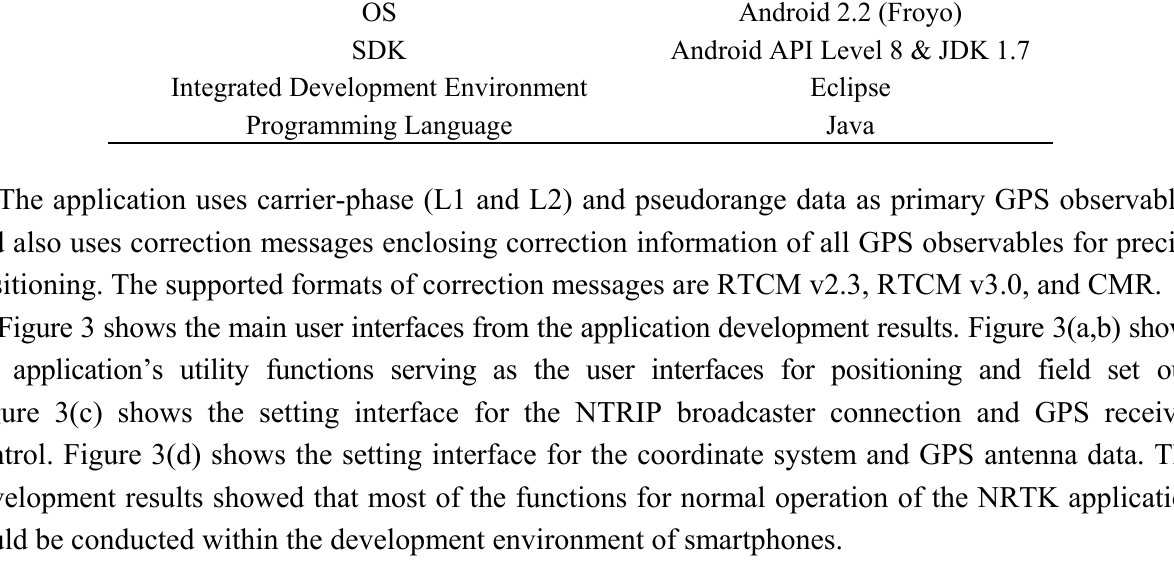
Figure 3. Application development results (main user interfaces and operation